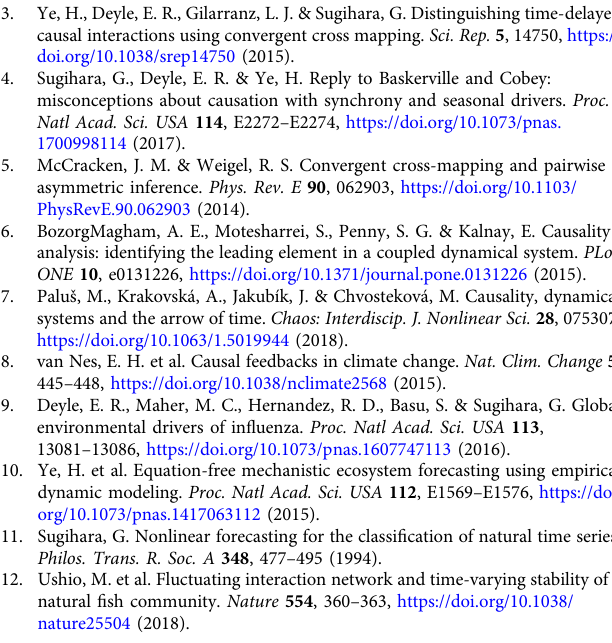
Fig. 2 CCM analysis for paired white noises. White noise time series were generated from 10,000 simulations and all time series were trimmed to length = 10, following Yang et al. 1 . In total, we performed CCM analyses between 1000 random pairs of white noises. To evaluate convergence of CCM, we calculated three indices: a improvement in CCM skill from minimal ( L = 2) to maximal library length ( L = 10); b p value for testing the signi fi cance of the improvement in CCM skill using Fisher ’ s Δ ρ Z test; and c p value for testing the signi fi cance of monotonic increasing trend in CCM skill using Kendall ’ s τ test. In a majority of cases, improvements in CCM skill were very small and close to zero, indicating no convergence ( a ). As such, false positives in both Fisher ’ s Z test ( b ) and Kendall ’ s τ